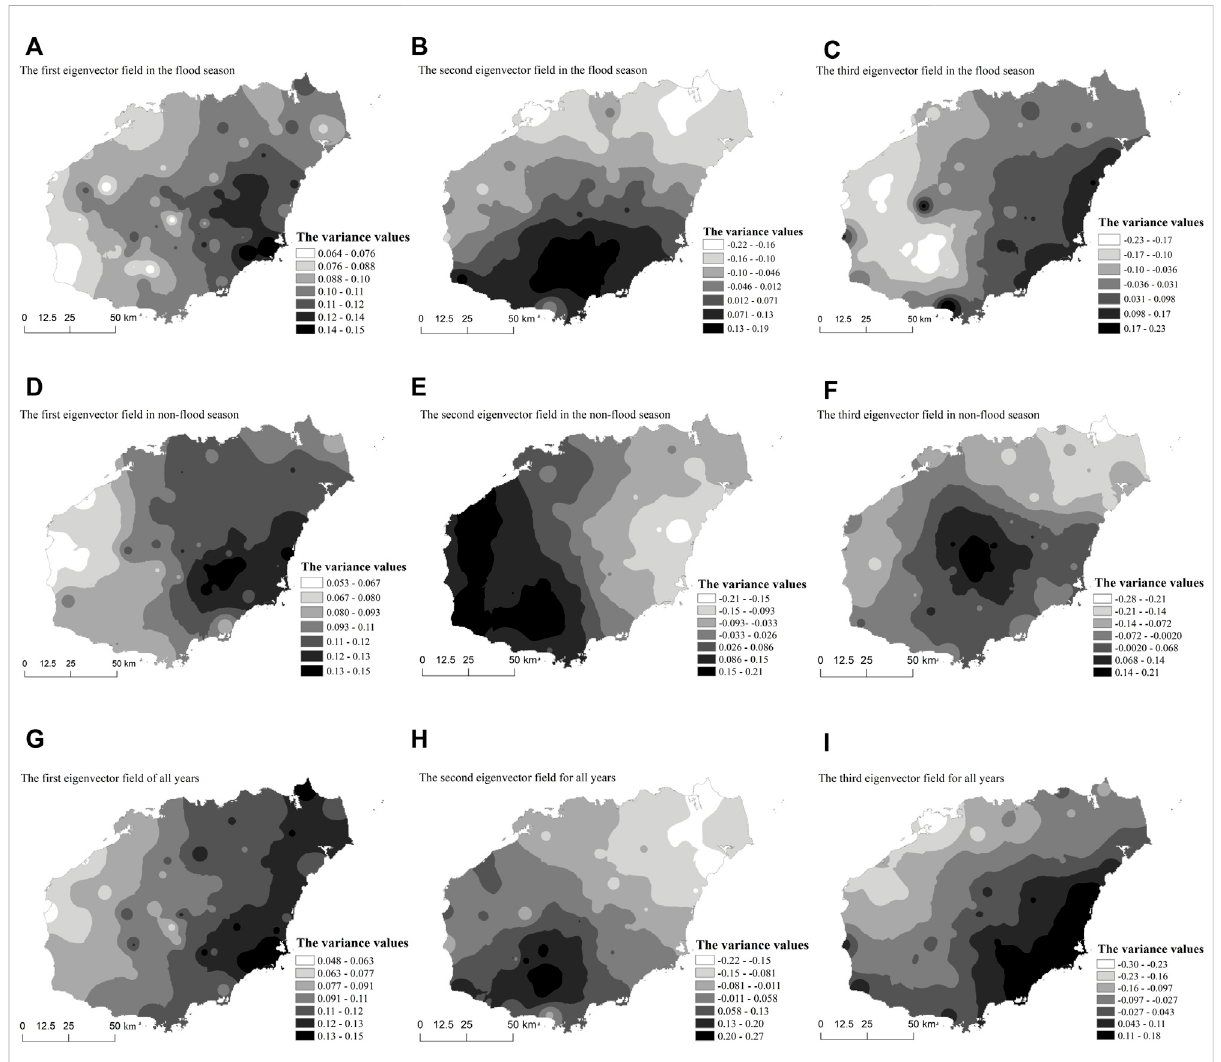
FIGURE 4 Spatial distribution of EOFs of the fi rst three eigenvector fi elds in the fl ood season (A – C) , non- fl ood season (D – F) and the whole year (G – I) in Hainan Island.